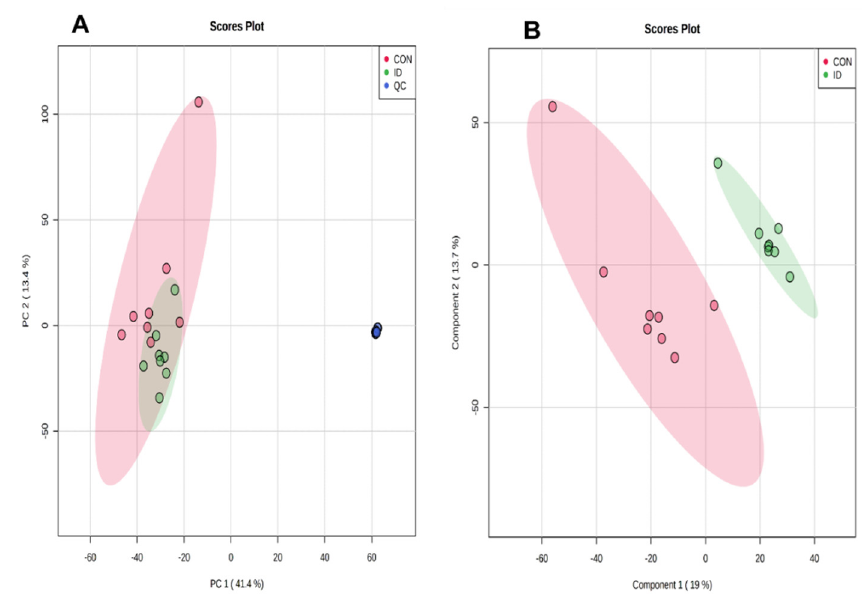
Figure 1. ( A ) Principal component analysis (PCA) score plot of serum metabolites of neonatal piglets with or without iron supplementation. ( B ) Partial least squares discriminant analysis (PLS-DA) score plot of metabolites of pigs with or without iron supplementation.